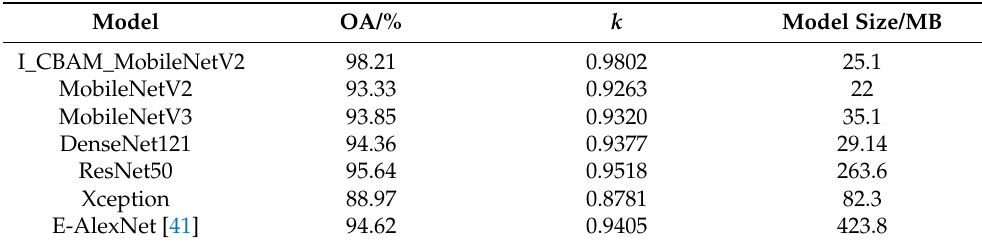
Table 5. Quantitative evaluation results of different models.